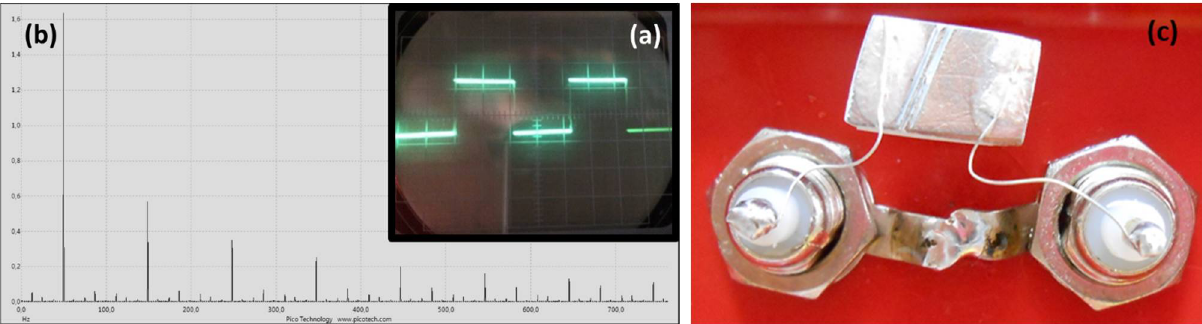
Figure 4. Square-wave signal ( a ) with its harmonic analysis by FFT oscilloscope ( b ) and sensor prototype ( c ).